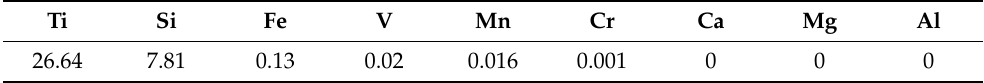
Table 4. Composition of leaching solution under the conditions of F − concentration at 14 mol/L, leaching temperature of 90 ◦ C for 20 min with L / S ratio of 20:1, rotating speed of 200 r/min (g/L). Ti Si